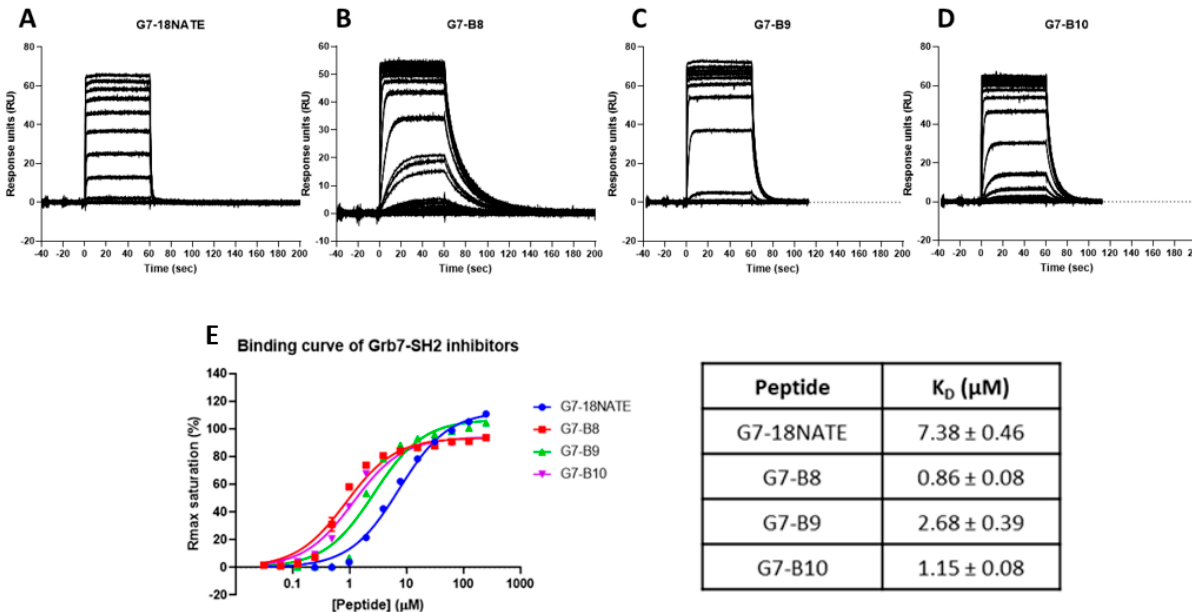
Figure 2. SPR binding analysis of newly developed Grb7-SH2-targeting peptides. Sensograms acquired for ( A ) G7-18NATE, ( B ) G7-B8, ( C ) G7-B9, and ( D ) G7-B10 peptides binding to the Grb7-SH2 domain. Peptide concentrations ranged from 0.015 to 250 µ M. ( E ) Binding curves derived for each peptide concentration at steady-state and equilibrium binding constants (K D ), calculated using a single-site binding model. Errors are SD arising from